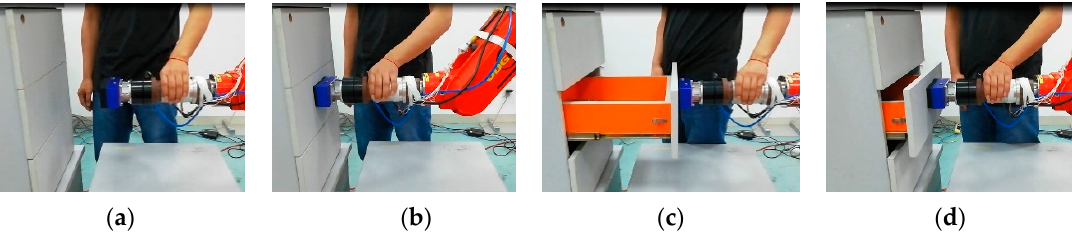
Figure 24. Human-robot cooperate to finish drawer switch experiment: ( a ) approach to the target; ( b ) grab the target; ( c ) open switch ( d ) close switch.